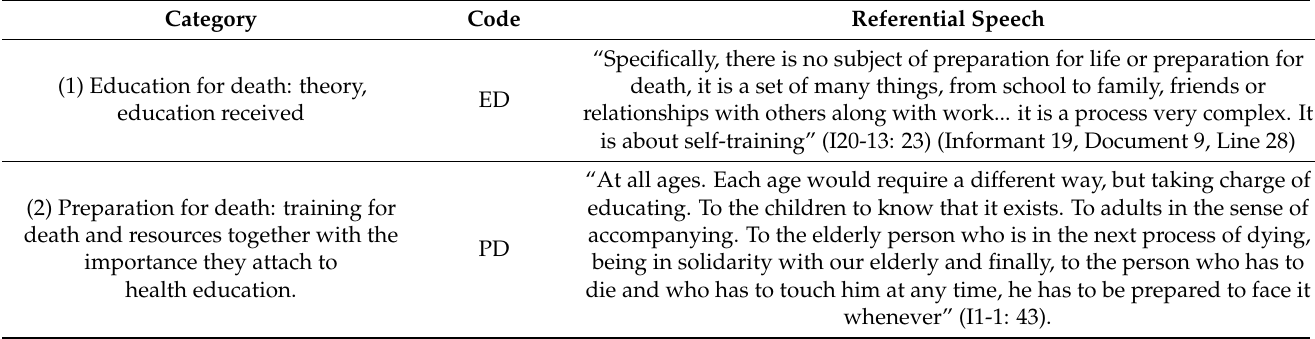
Figure 2. Semantic network Atlas.Ti.